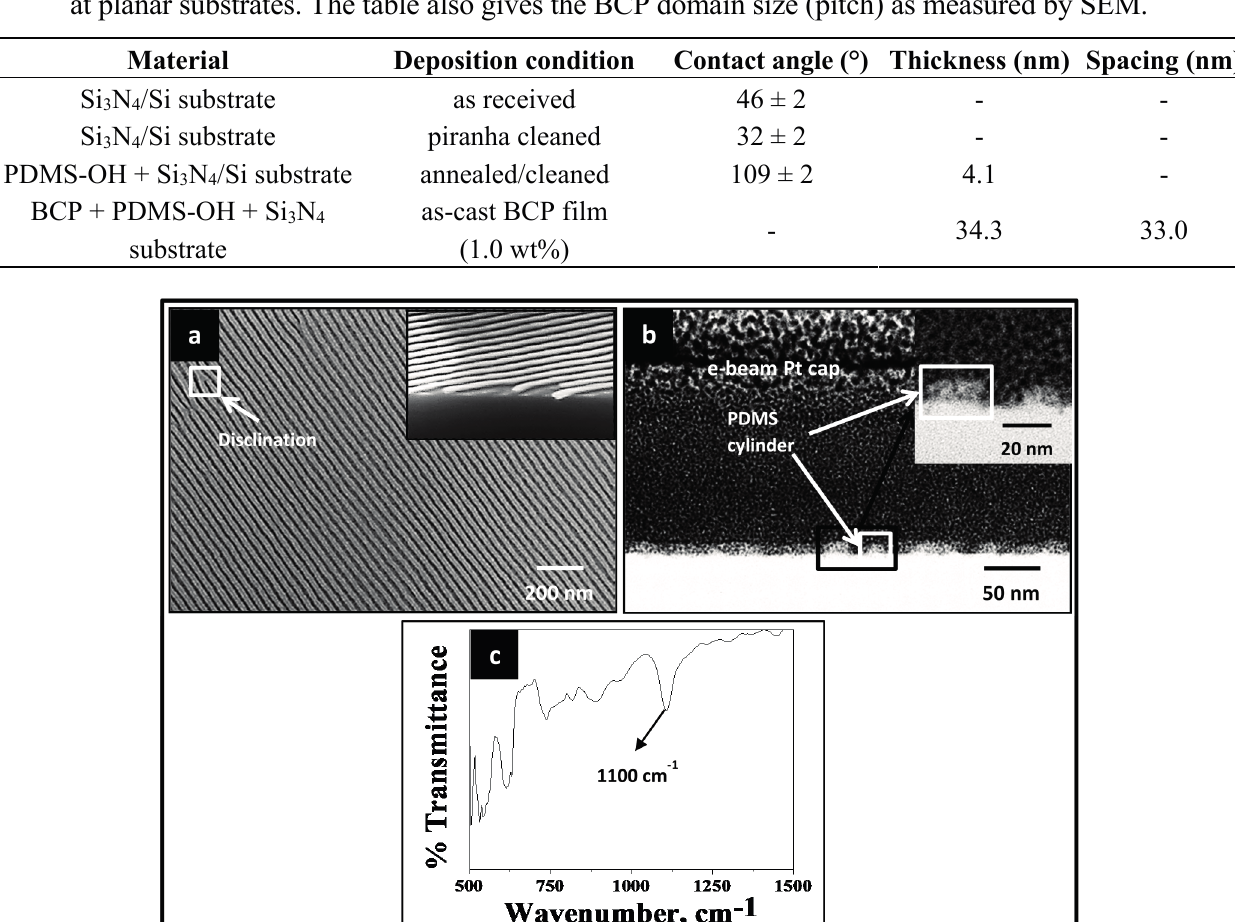
Figure 1. ( a ) Top-down SEM image of the PS- b -PDMS structure at a planar Si 3 N 4 substrate following microwave treatment at 50 °C for 30 s in toluene (light grey lines are